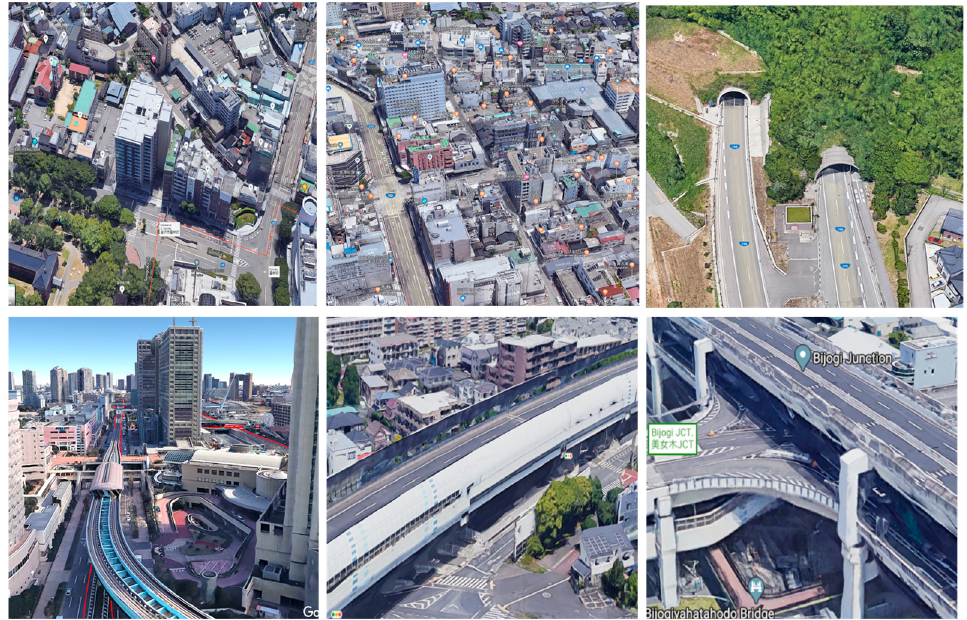
Figure 2. Challenging environments to be mapped by GIR. Dense trees, high buildings, long tunnels, covered roads by railway bridges, longitudinal tunnels and multilevel road structures.